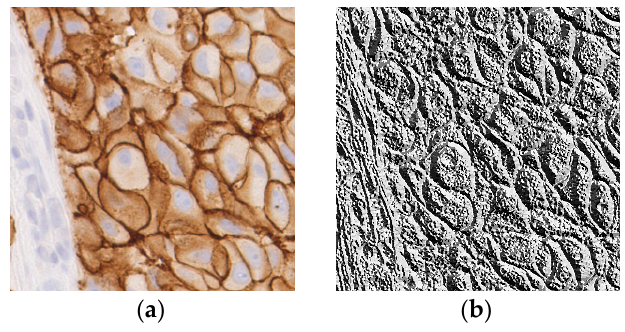
Figure 6. ( a ) A sample input image for LBP computation; ( b ) The corresponding LBP image.